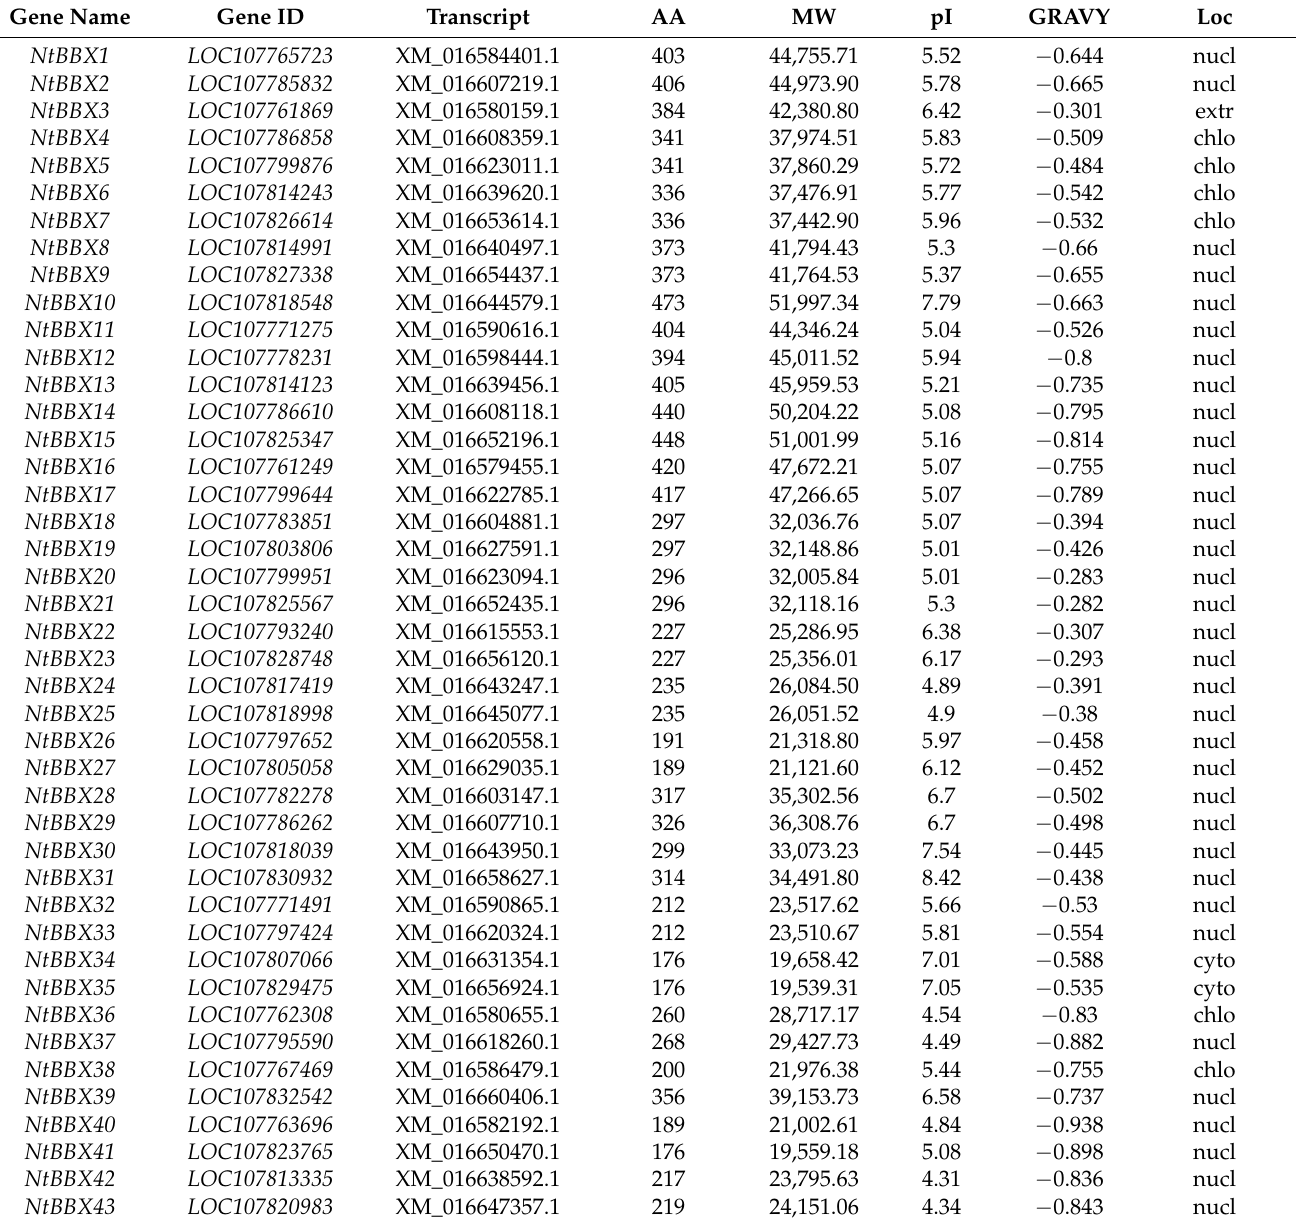
Table 1. The fundamental information of NtBBX